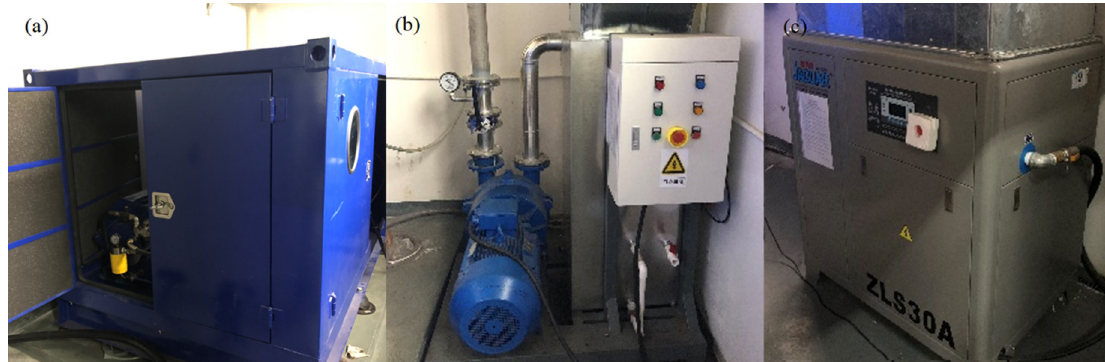
Figure 2. Experimental device for offering high pressure water jet ( a ) high pressure pump; ( b ) vacuum pump; ( c ) air compressor.